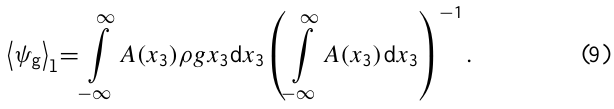
Fig. 2. A fine-textured soil at hydrostatic equilibrium with differ- ent phreatic levels. In the left pane the phreatic level is at such a depth that the capillary fringe exactly reaches the soil surface. The menisci at the soil surface are curved, but all pores are saturated. In the right pane, just enough water was added to flatten these menisci. As a result the phreatic level (where the water is at atmospheric pressure) moved up to the soil